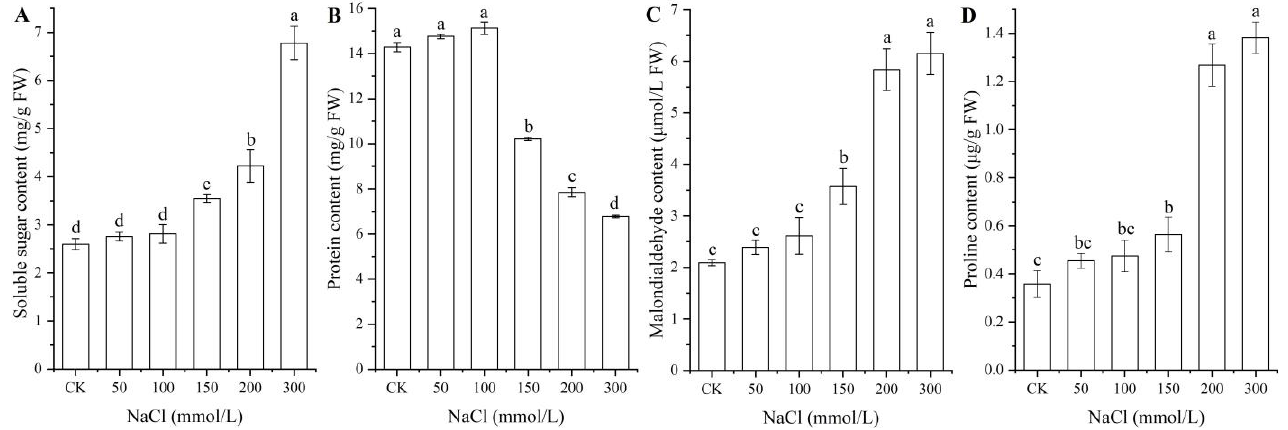
Figure 3. Changes in the contents of soluble sugar ( A ), protein ( B ), MDA ( C ), and proline ( D ) in A. venetum seeds under different NaCl treatments. Different letters represent a significant difference ( p < 0.05) among different NaCl treatments.